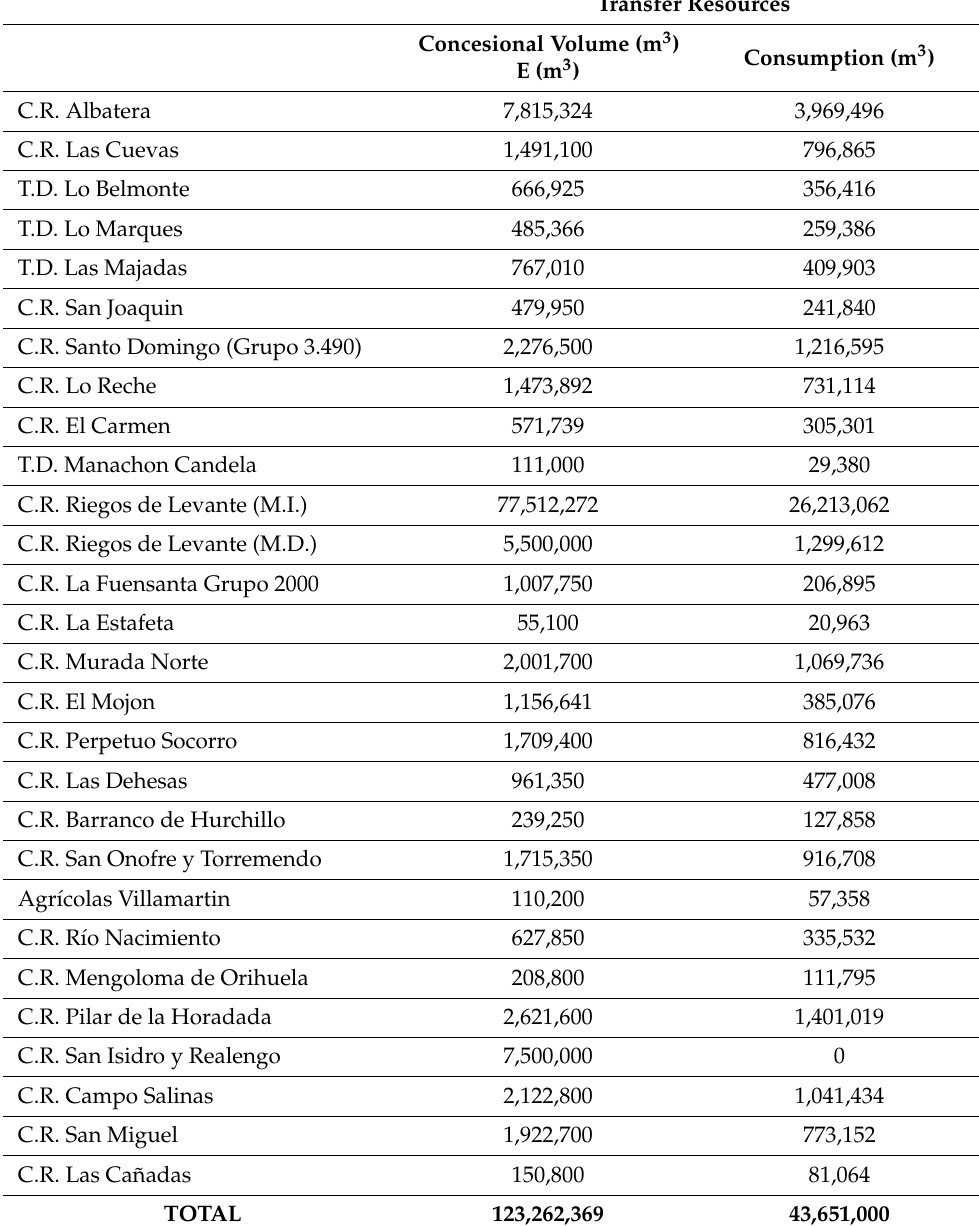
Table 11. Volume of water supplied by the water transfer to the CC.RR. of Alicante in the